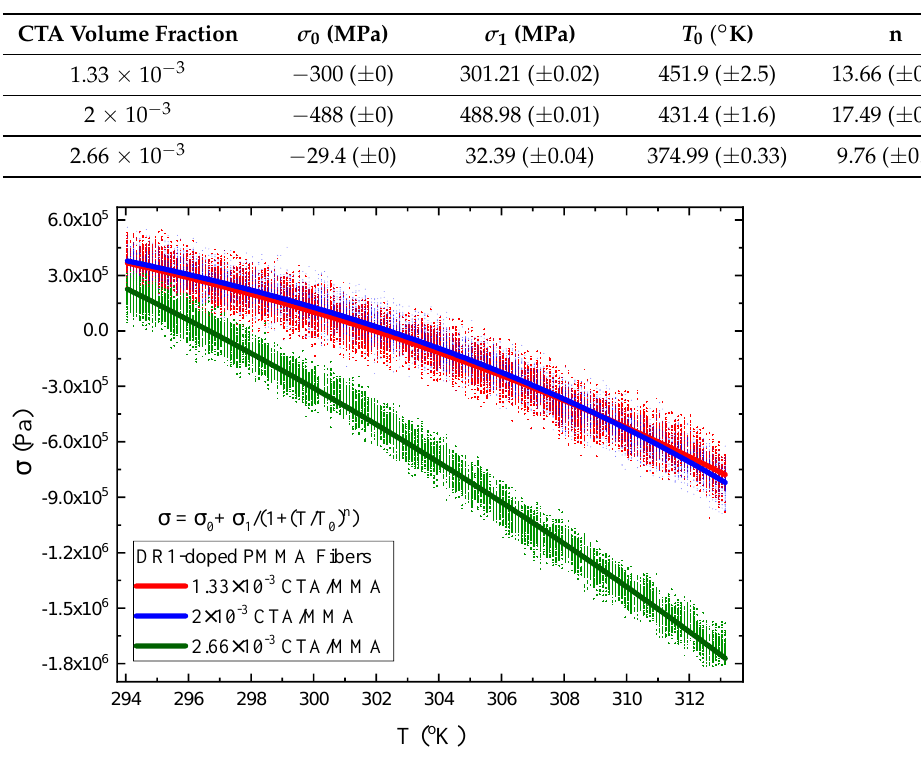
Figure 9. Measured stress as a function of temperature for clamped DR1-doped PMMA fibers at three different CTA volume fractions (points) and fits to the model given by Equation